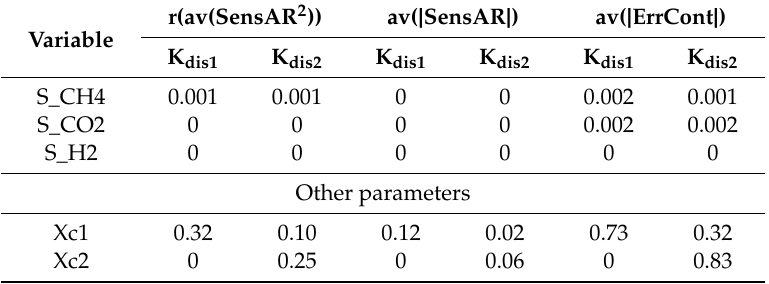
Table A2. Variables ranked based on sensitivity to K dis1 and K dis2 in the bulk reactor (RF).